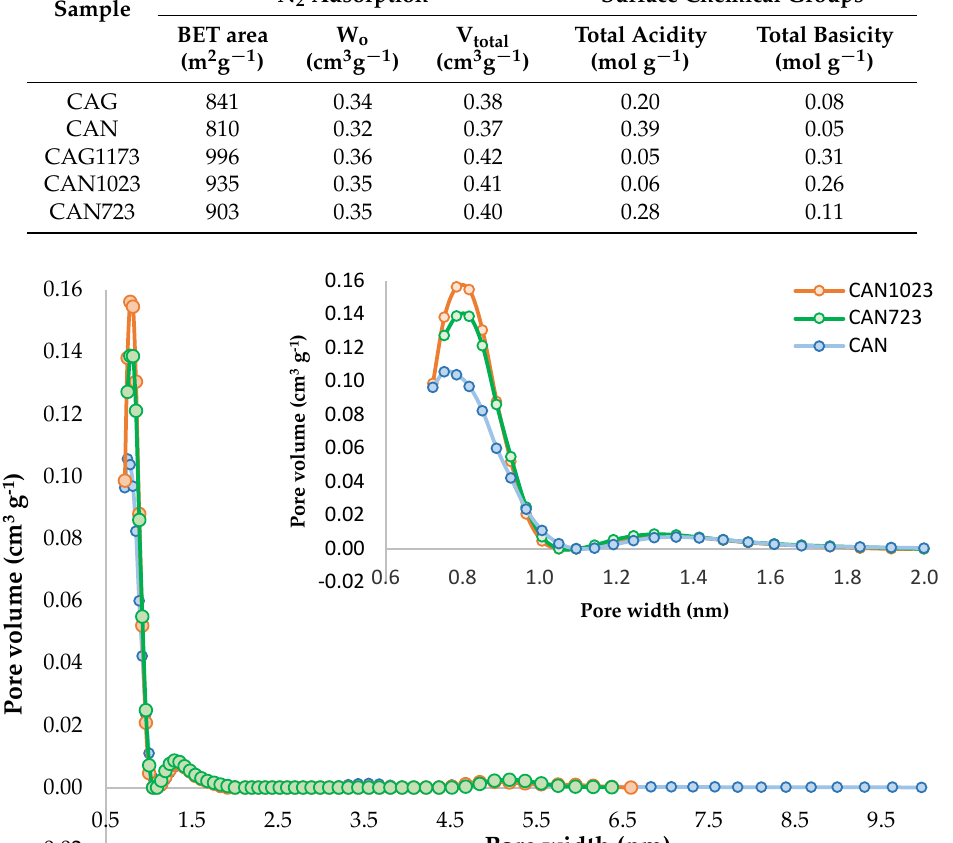
Figure 1. Pore size distribution (PSD) for oxidized activated carbon (CAN), CAN723, and CAN1023 according to the quenched solid density functional theory (QSDFT) model.